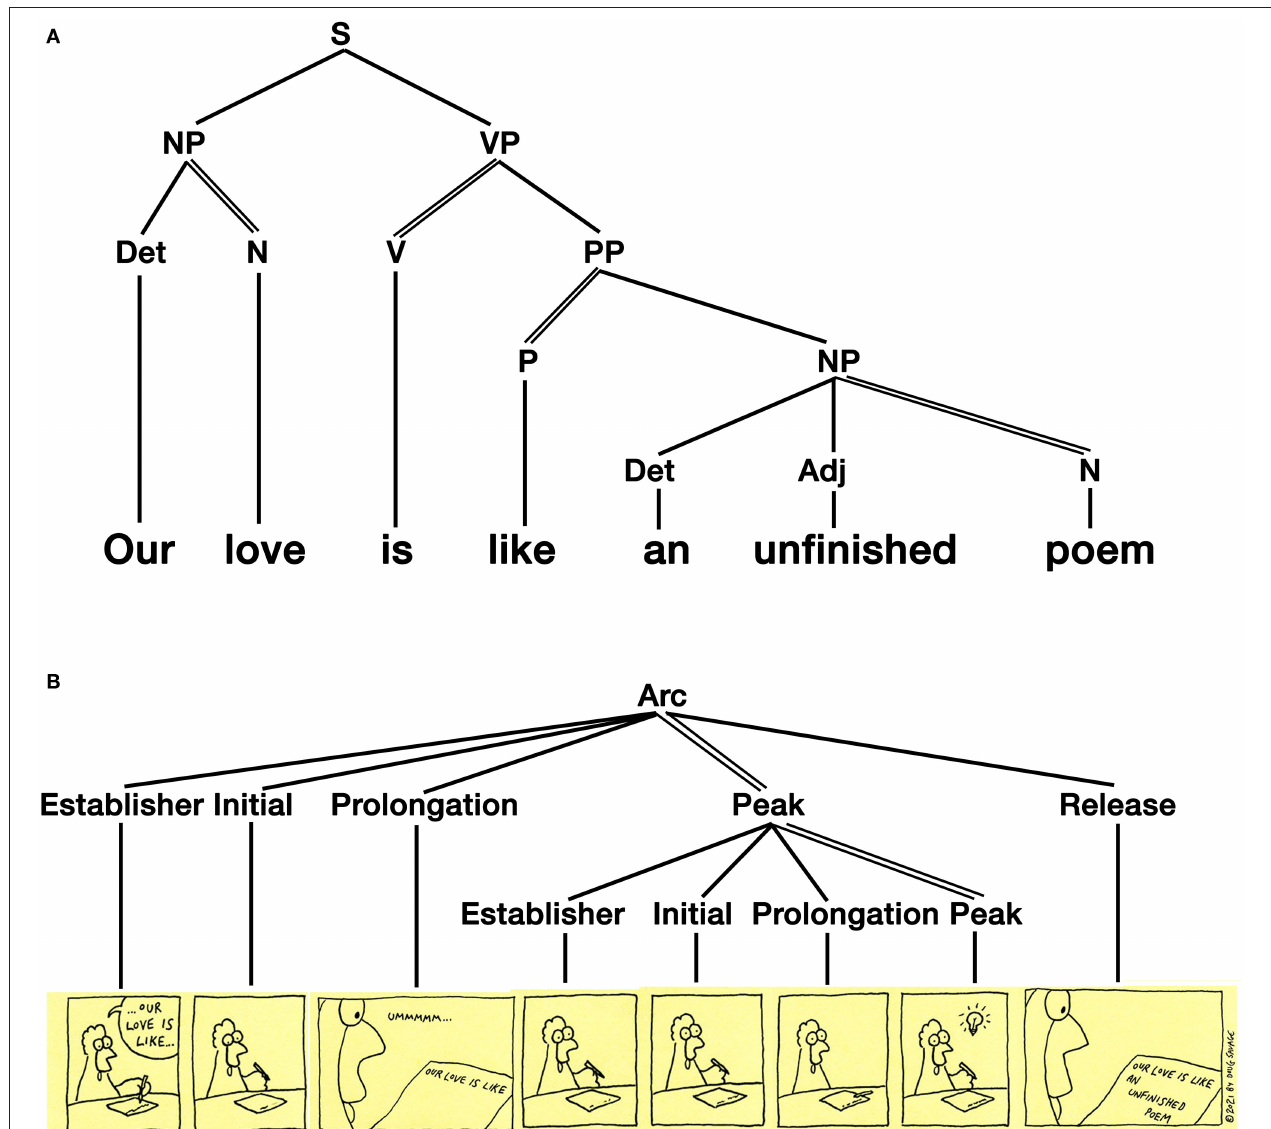
FIGURE 5 | Grammatical structures in both (A) the syntactic structure of spoken languages and (B) as the narrative structures of visual languages. Savage Chickens is © 2021 Doug Savage.